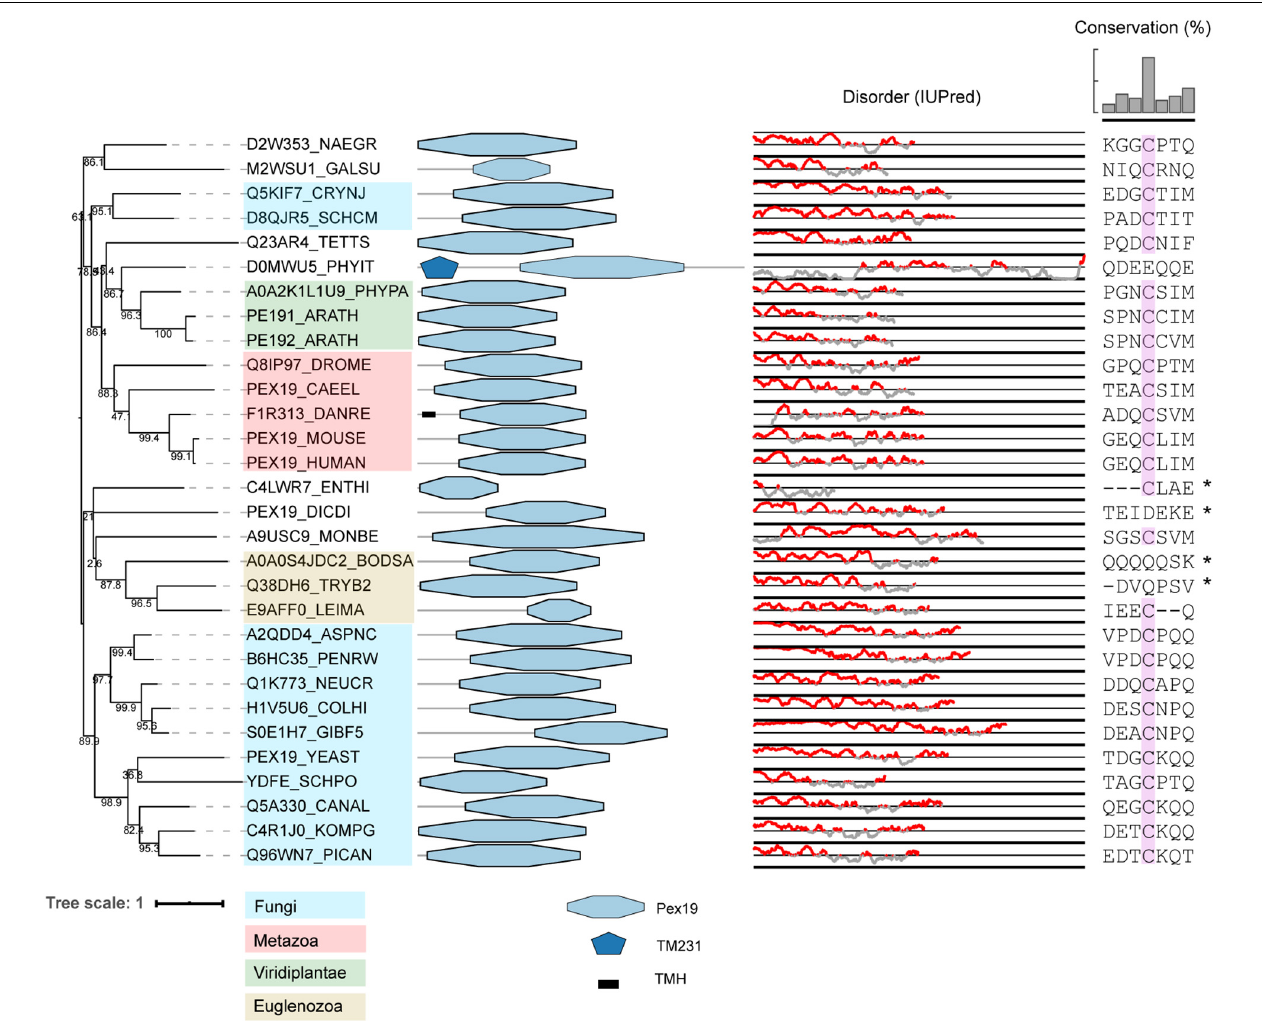
FIGURE 3 | Phylogeny and protein features of PEX19 orthologs. The phylogeny is rooted at mid-point to ease the visualization and labels of the main taxonomic groups are colored according to the legend. Note that the topology does not necessarily reflect the actual evolutionary trajectory of such proteins. Protein domain architecture is defined by pfam annotations and transmembrane helices (TMH) according to TMHMM software. The line-dot plot, indicates the regions predicted to be disordered (red) and not disordered (gray). The sequence alignment shows the conservation of the CaaX box in PEX19 orthologs of distant eukaryotes, with